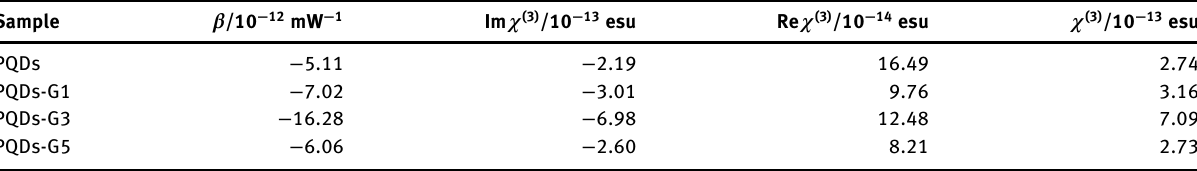
Table 1: The nonlinear susceptibilities of the samples.